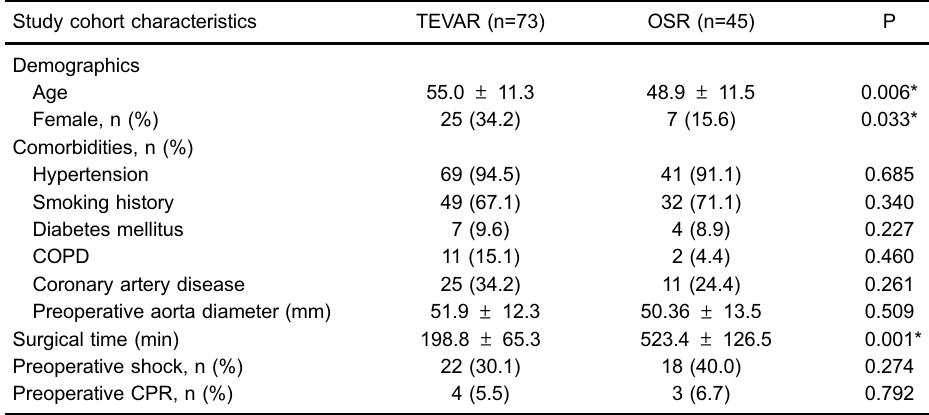
Data are reported as means ± SD, or number and percentages. OSR: open surgical repair; TEVAR: thoracic endovascular aortic repair; COPD: chronic obstructive pulmonary diseases; CPR: cardiopulmon- ary resuscitation. *P o 0.05, chi-square test was used for categorical variables and t-test was used for continuous